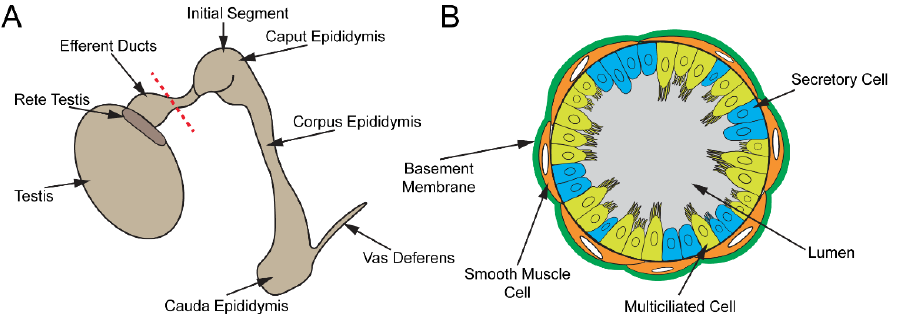
Figure 3. Male reproductive tract. ( A ) Cartoon schematic of the male reproductive tract. Sperm are produced in the seminiferous tubules of the testis, collected in the rete testis, and transported to the epididymis via EDs, where they mature. Mature sperm are stored in the cauda epididymis and released through the vas deferens. ( B ) Depiction of a cross ‐ section of the ED along the red dashed line in ( A ). The ED epithelium consists of MCCs and secretory cells.